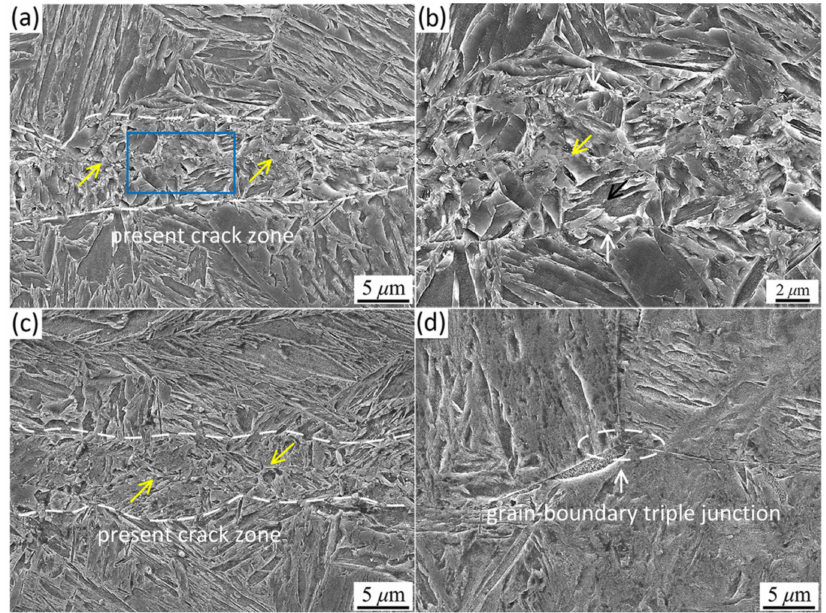
Figure 2. SEM micrographs of crack healing zone at different healing times for 60 min: ( a , b ) 1000 ◦ C; ( b ) magnified image of the selected region in Figure 2a showing dividing lines (yellow arrow) and recrystallized grains (black arrow); ( c ) 1100 ◦ C; ( d ) 1200 ◦